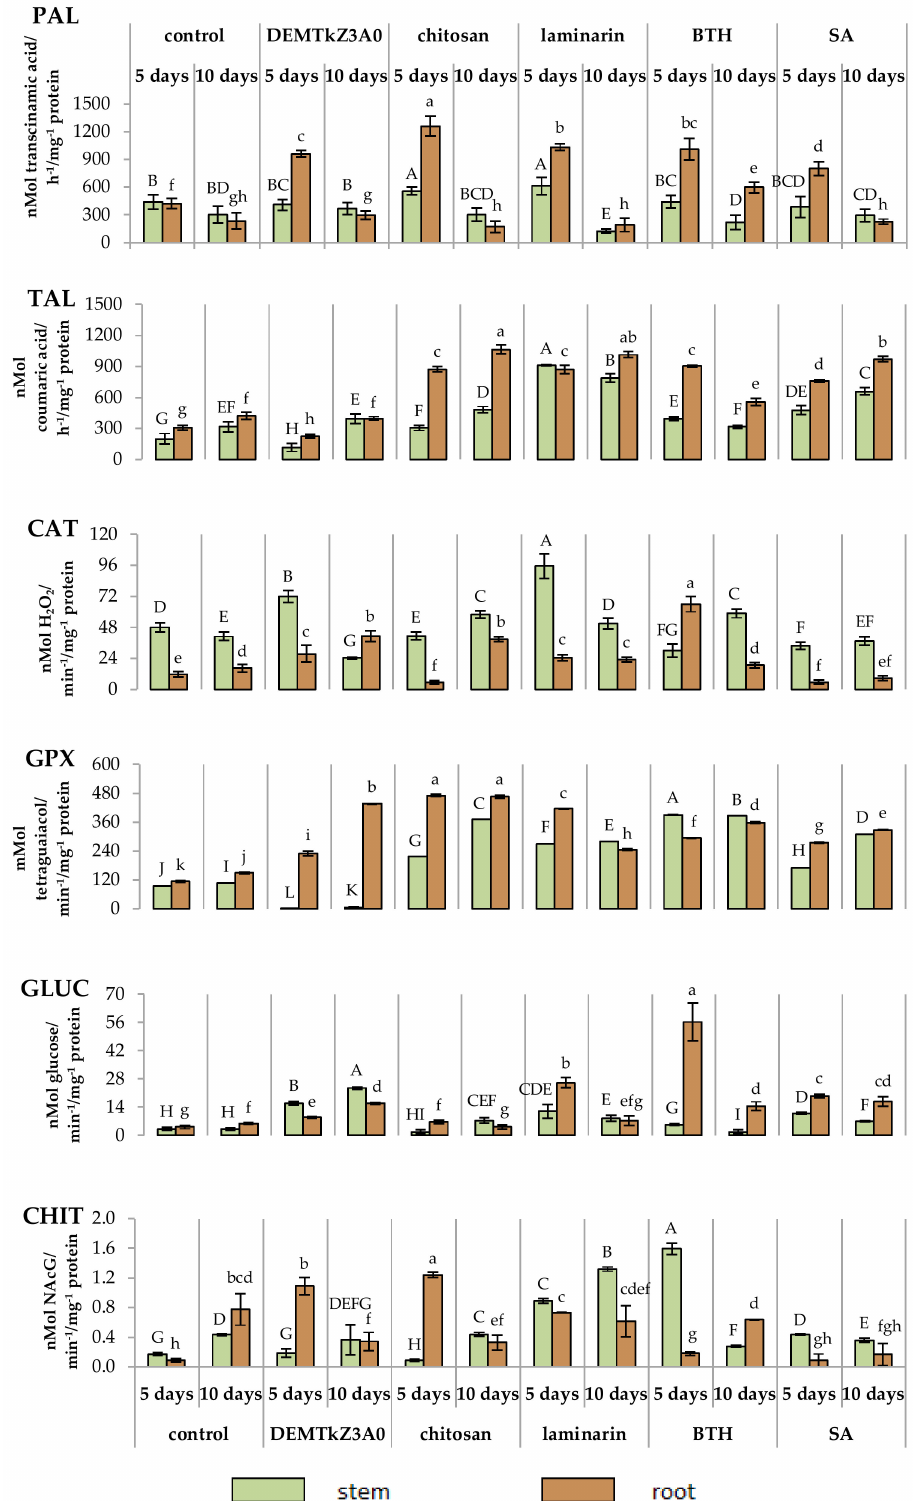
Figure 17. The activity of plant resistance markers (PAL—phenylalanine lyase, TAL—tyrosine lyase, CAT—catalase, GPX—guaiacol peroxidase, GLUC—glucanase, CHIT—chitinase) in the stems and roots of wheat after 5 and 10 days inoculation with Trichoderma DEMTkZ3A0 strain and potential inducers od plant resistance: Chitosan, laminarin, BTH, and